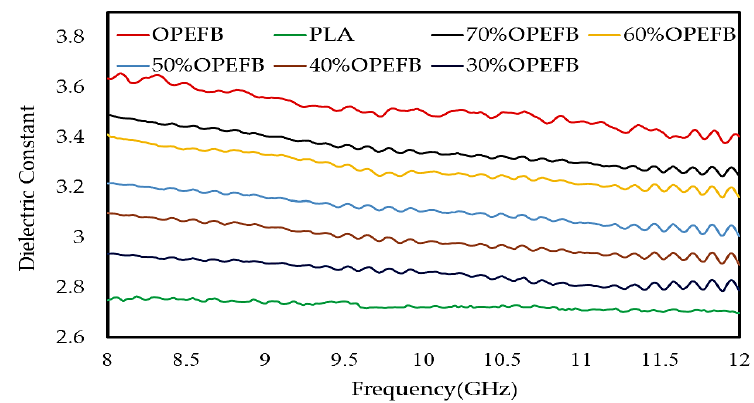
Figure 8. Variation in dielectric constant of OPEFB/PLA composites at different percentages of OPEFB filler.